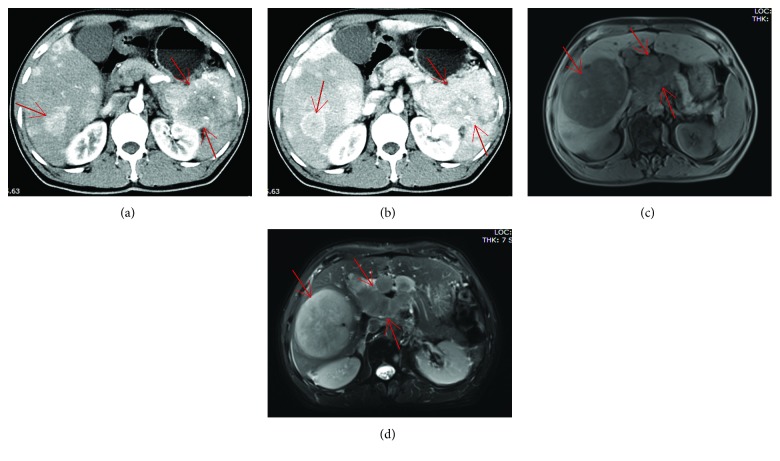
Image examination of gastroenteropancreatic neuroendocrine carcinomas with liver metastasis. (a, b) Contrast-enhanced CT showed the uneven mass of the soft tissue in the pancreas tail with the size of about 8 × 7 cm. The mass was scattered in the point of patchy high-density calcification, and the mass and pancreatic body part of the boundary are unclear. The liver showed multiple sizes of nodules with abnormal enhancement. (c, d) MRI showed multiple round nodules around the head of the pancreas and retroperitoneum, which were similar to the signal and enhancement pattern in the liver, and the pancreatic head was compressed. The liver showed multiple round long T1 signals, a slightly longer T2 signal shadow, and a smooth edge. The larger nodule is located in the right lobe of the liver with a size of about 7.7 × 11.8 × 10.6 cm.